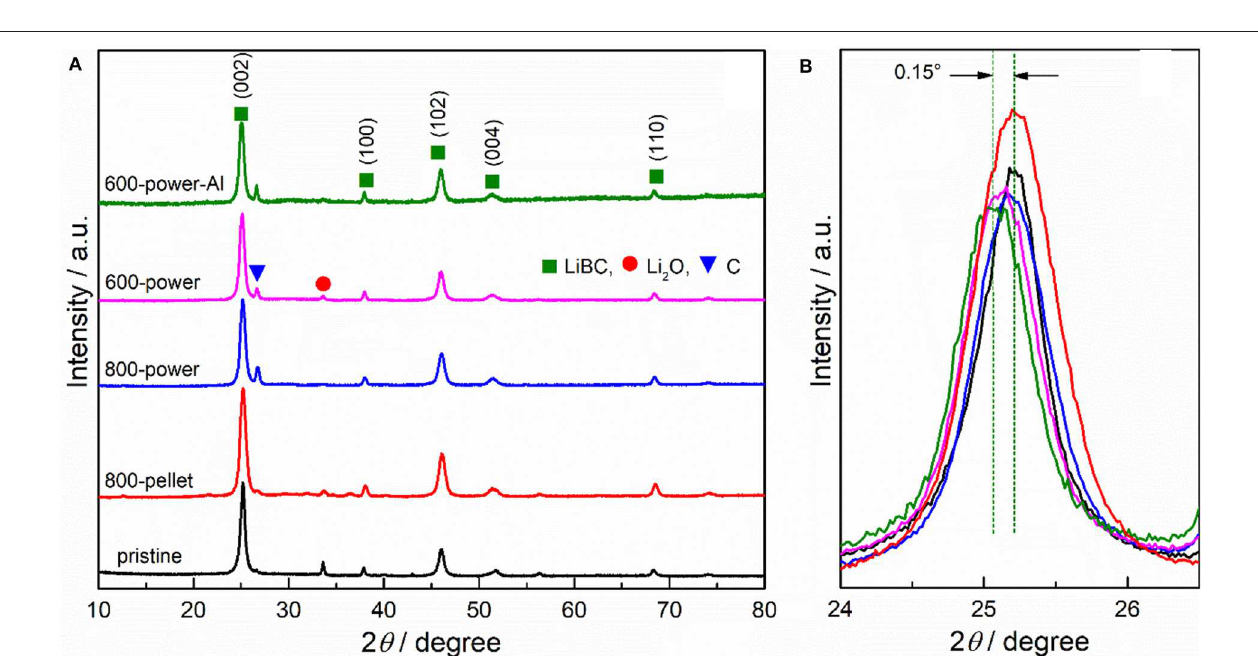
FIGURE 3 | (A) The XRD patterns for five LiBC samples and (B) the enlarged views for Peak (002).